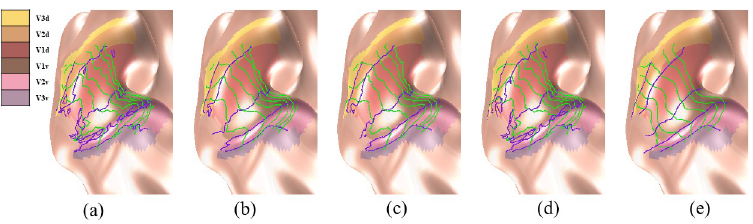
Fig 11. Visual area boundary delineation of the V1/V2/V3 complex of the first observer. The colors of the surface represent manually labeled visual areas from the average data. The purple curves indicate boundaries between visual areas of V3d/V2d/V1d/V1v/V2v/V3v (from up to down), respectively. The green curves are eccentricity contours. (A) boundaries inferred from the raw data, and (B)-(E) boundaries after average, median, Laplacian, and topological smoothing.